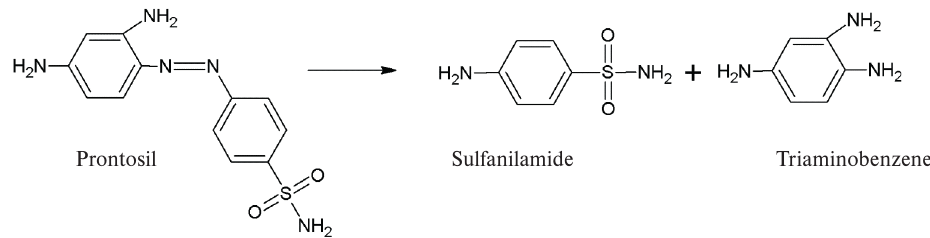
Fig. 1. azo reduction of prontosil is one example, where intestinal bacteria convert inactive therapeutics into their pharmaco- logically active form. Bacterial azoreductases present in the distal gut cleave the N-N double bond and produce active metabolite sulfanilamide.